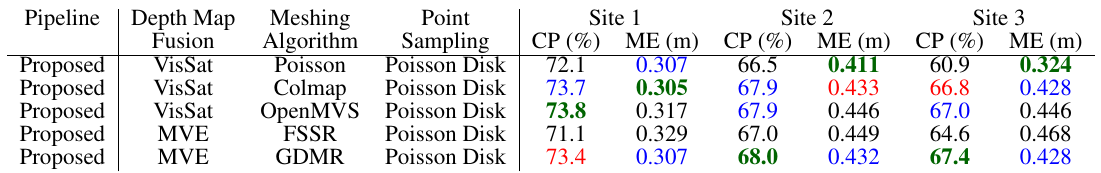
Table 2. Quantitative evaluation of the proposed pipeline with different state-of-the-art surface reconstruction algorithms. The surface points used to compute the metrics are extracted with poisson disk sampling. The evaluated surface reconstruction methods include Poisson (Kazhdan and Hoppe, 2013), Colmap (Sch¨onberger et al., 2016; Labatut et al., 2009), OpenMVS (Cernea, 2021; Jancosek and Pajdla, 2014), FSSR (Fuhrmann and Goesele, 2014) and GDMR (Ummenhofer and Brox, 2017). FSSR and GDMR require scale information for each point in the fused point cloud to triangulate the corresponding mesh. In this case we substitute the depth map fusion approach of VisSat (Zhang et al., 2019) with the equivalent processing step of MVE (Goesele et al., 2007). The metrics completeness (CP) ↑ and median error (ME) ↓ follow the definition by Bosch et al. (2016). The top three results are highlighted in